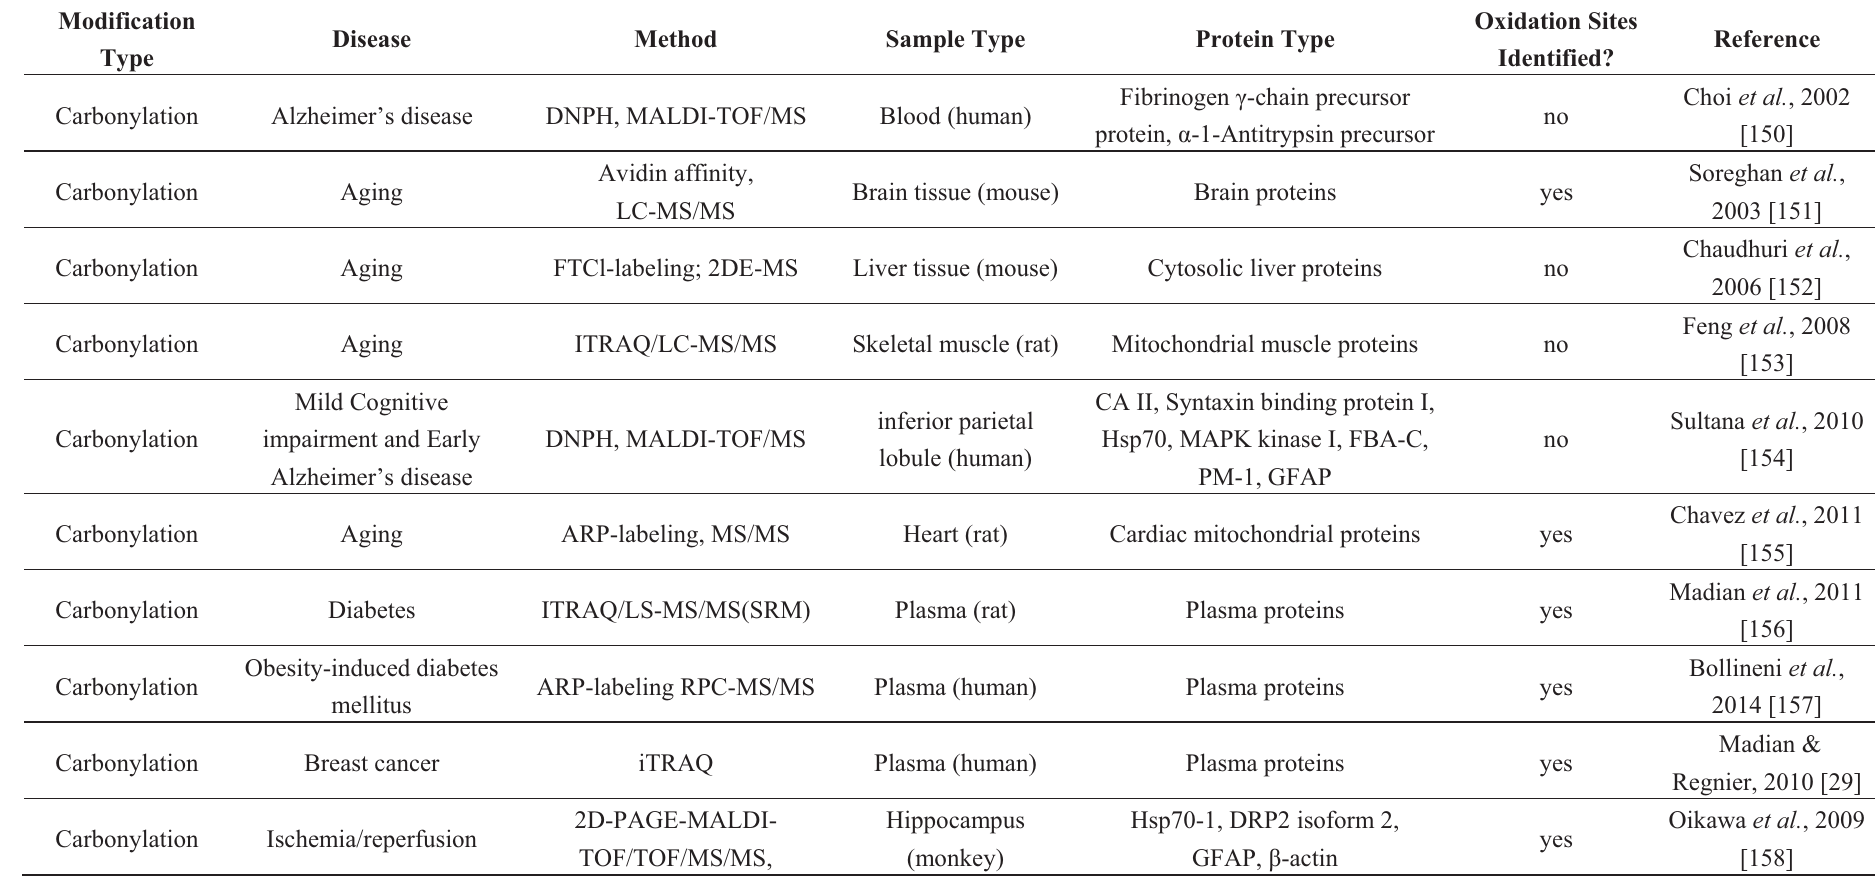
Table 2. Summary of recent studies where increased levels of oxPTMs in disease have been detected using MS techniques